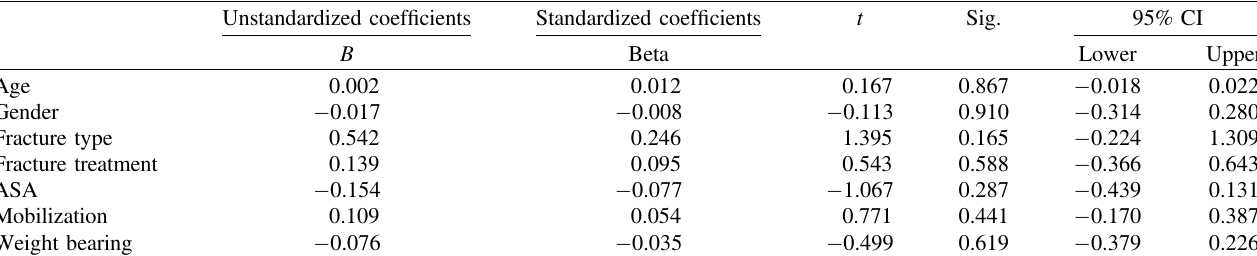
Table 4. Predictors for pain.